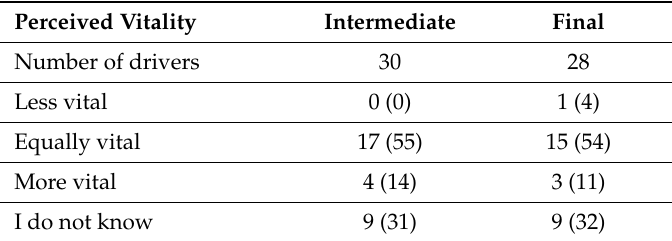
Table 6. Perception of e ff ectiveness ( N (%)) of the toolbox on vitality according to the drivers’ perception in the intermediate and final measurements, based on the following question: Do you have the feeling that you are more vital now then you would have been without the use of the